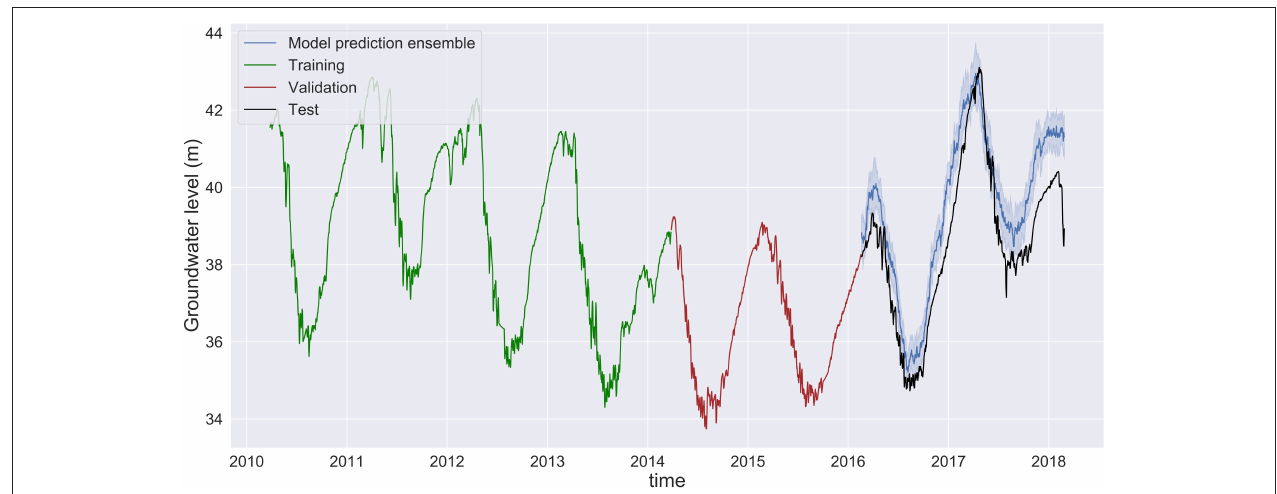
FIGURE 6 | Groundwater level prediction at Butte with input features: groundwater level, temperature, precipitation, and river flow (G-T-P-Q-4-d). The small differences between the predicted groundwater levels (ensemble mean, dark blue) and the observed levels (black) indicate a high prediction accuracy. The narrow blue band around the mean prediction indicates higher reliability in model prediction, and thus low prediction variability. Predictions made by MLP models in Shasta and Tehama are provided in Supplementary Figures 1, 2 .